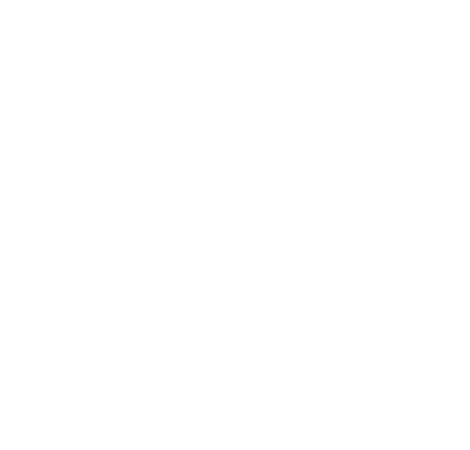
Figure 1. ORTEP of TpRu(NO)Ph 2 ( 2 ) with thermal ellipsoids at 50% probability. Hydrogen atoms are omitted for clarity. Only one of the three crystallographically independent but chemically identical molecules in the asymmetric unit is shown. Selected bond lengths (Å) and bond angles (°): Ru(1)-C(10) 2.098(6), Ru(1)-C(16) 2.084(7), Ru(1)-N(7) 1.728(5), N(7)-O(1) 1.151(6), Ru(1)-N(1) 2.119(5), Ru(1)-N(3) 2.174(5), Ru(1)-N(5) 2.167(6); Ru(1)-N(7)-O(1) 177.5(5), C(10)-Ru(1)-C(16) 93.8(2), N(1)-Ru(1)-N(3) 83.70(17), N(1)-Ru(1)-N(5) 81.95(19), N(3)-Ru(1)-N(5) 86.5(2).